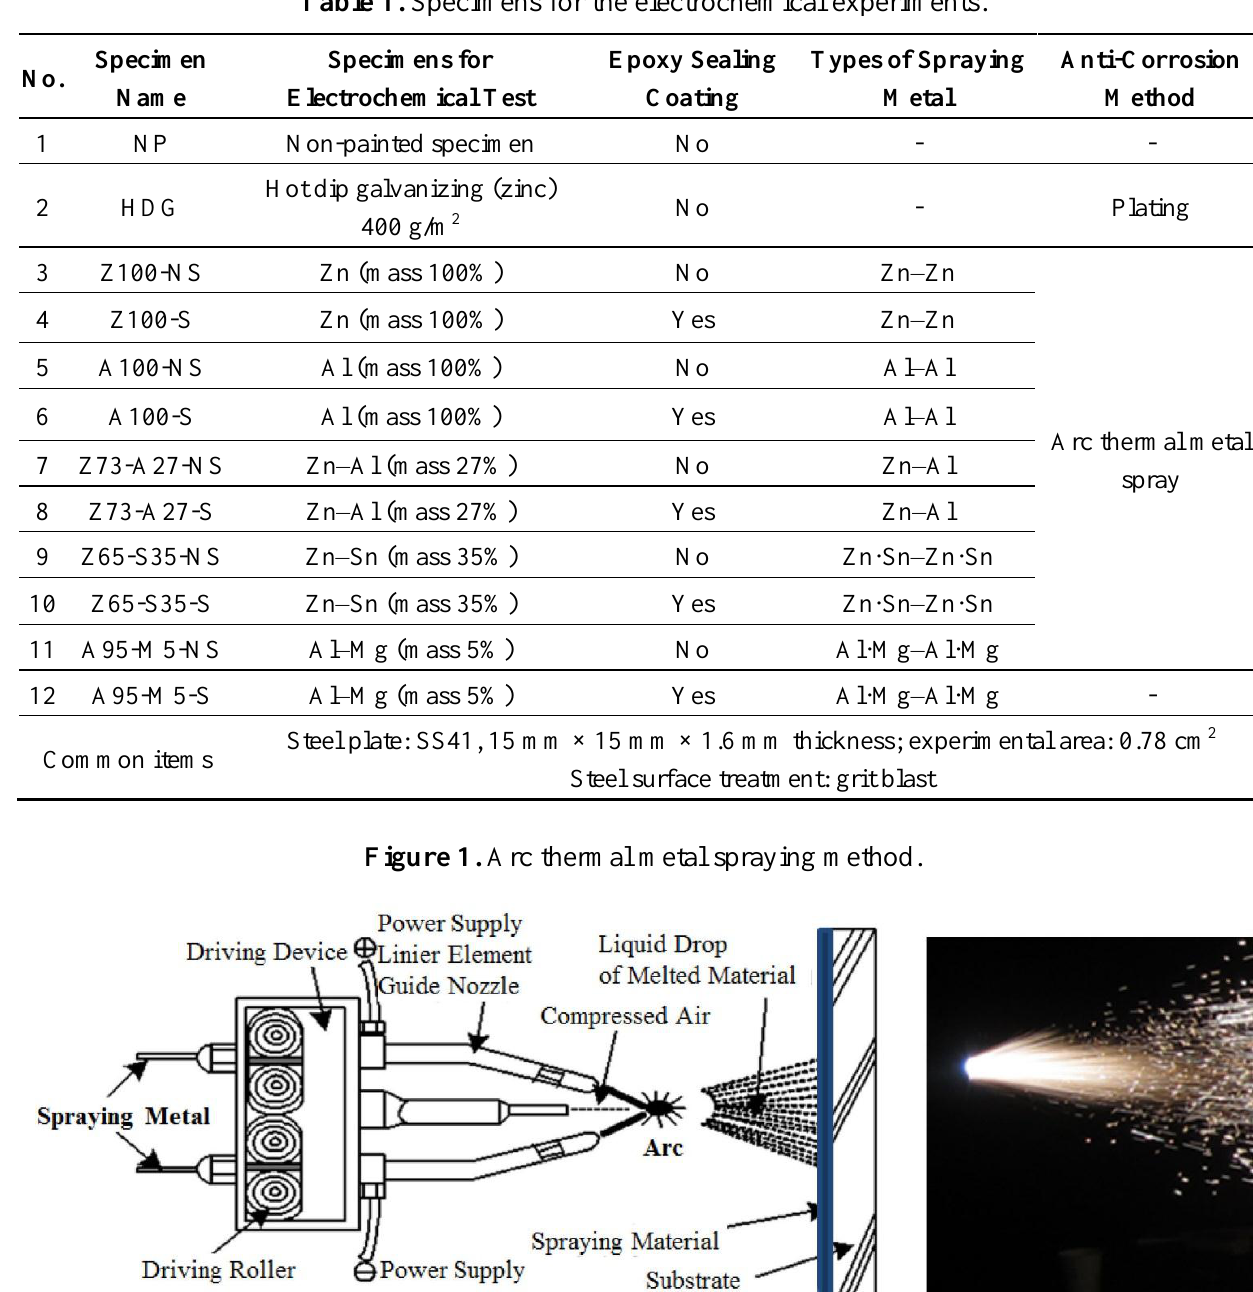
Table 1. Specimens for the electrochemical experiments.